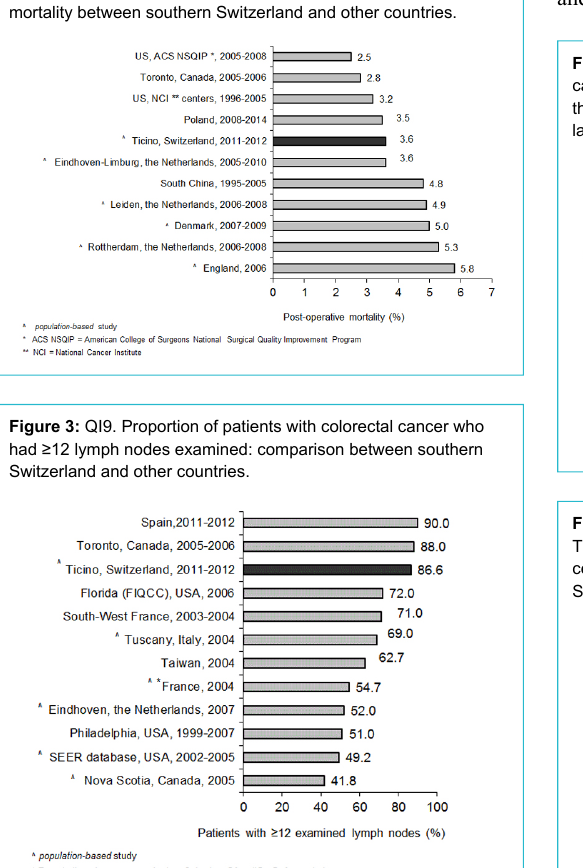
Figure 2: QI7. Proportion of patients with colorectal cancer who died within 30 days after surgery: comparison of postoperative mortality between southern Switzerland and other countries.